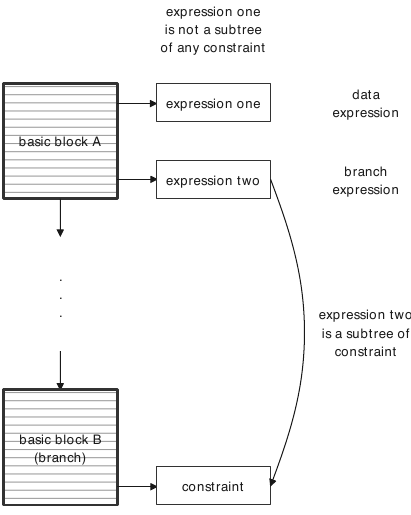
Figure 1. Data expressions and Branch expressions.